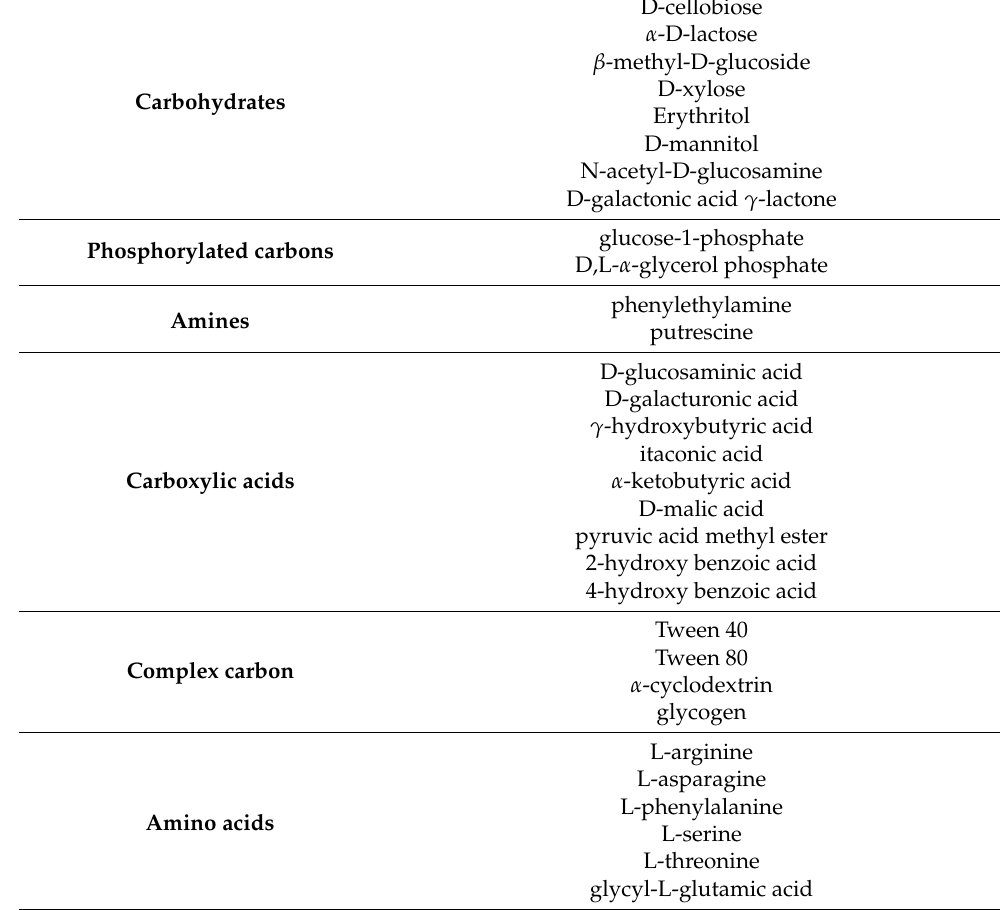
Table 1. Different carbon sources used by the Biolog EcoPlate method to measure the ability of the gut bacterial community of Daphnia to utilise carbon